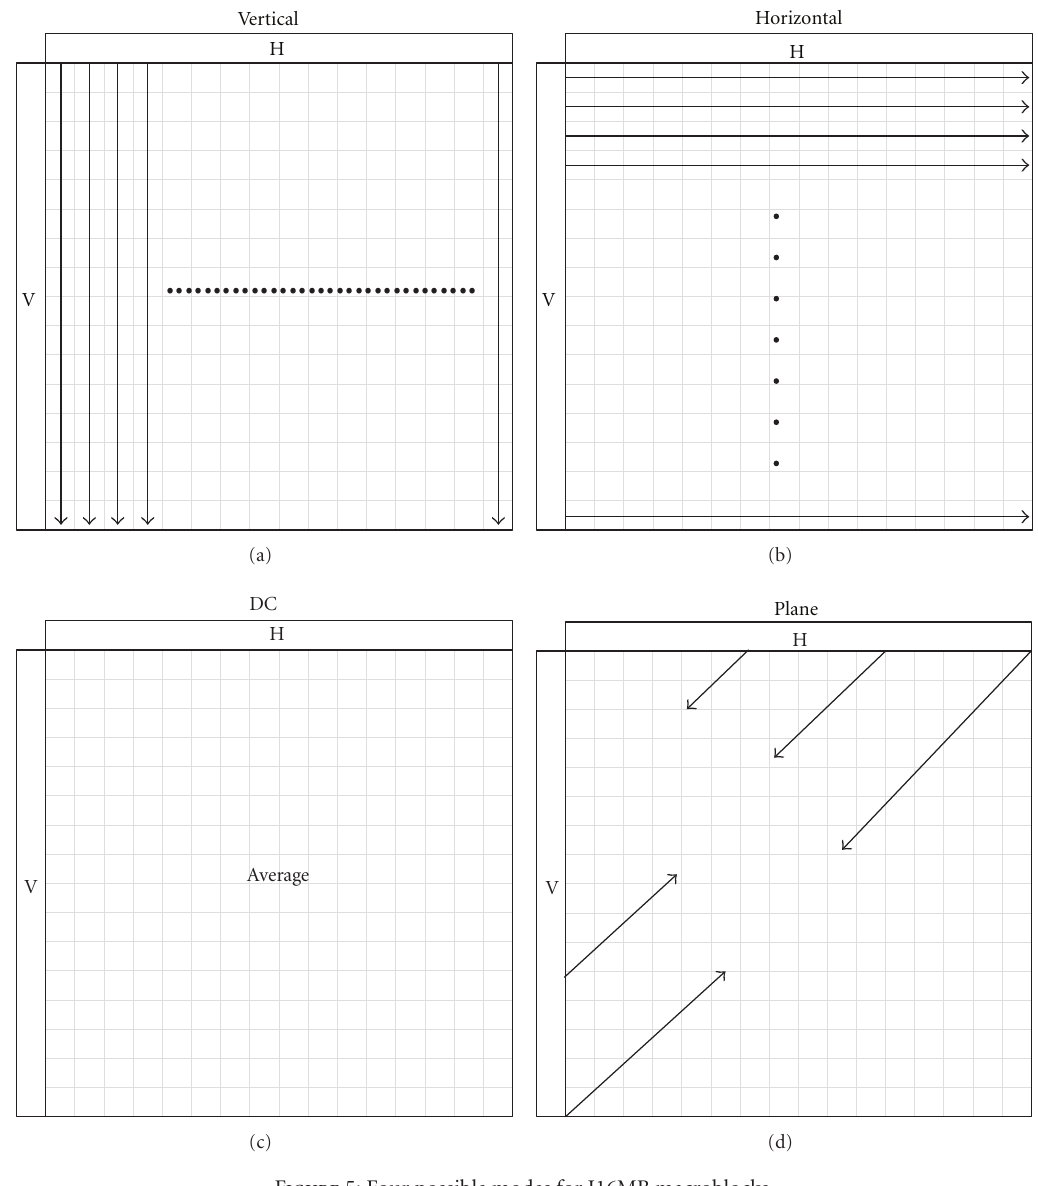
Figure 5: Four possible modes for I16MB